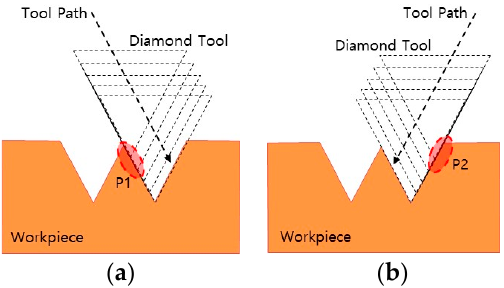
Figure 6. Machining with different tool paths: ( a ) changed tool path 1 (continuous contact area ‘P1’), ( b ) changed tool path 2 (continuous contact area ‘P2’).